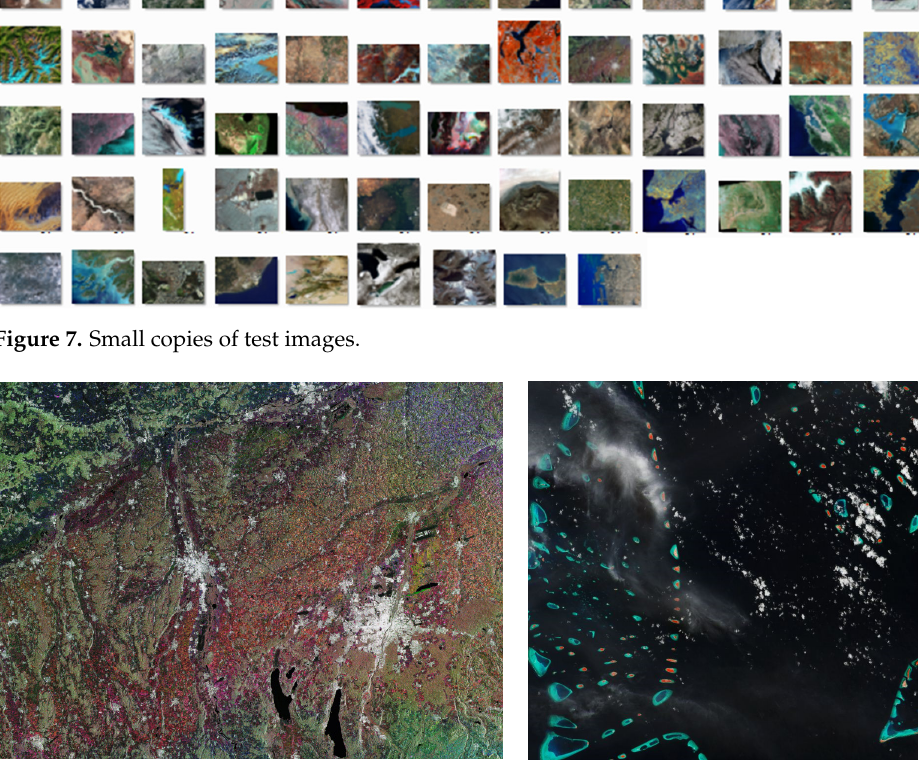
Figure 7. Small copies of test images.